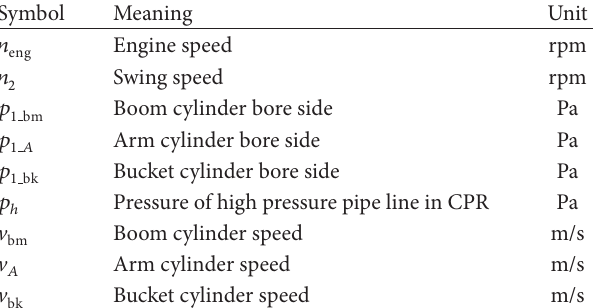
Table 2: Meanings of the state